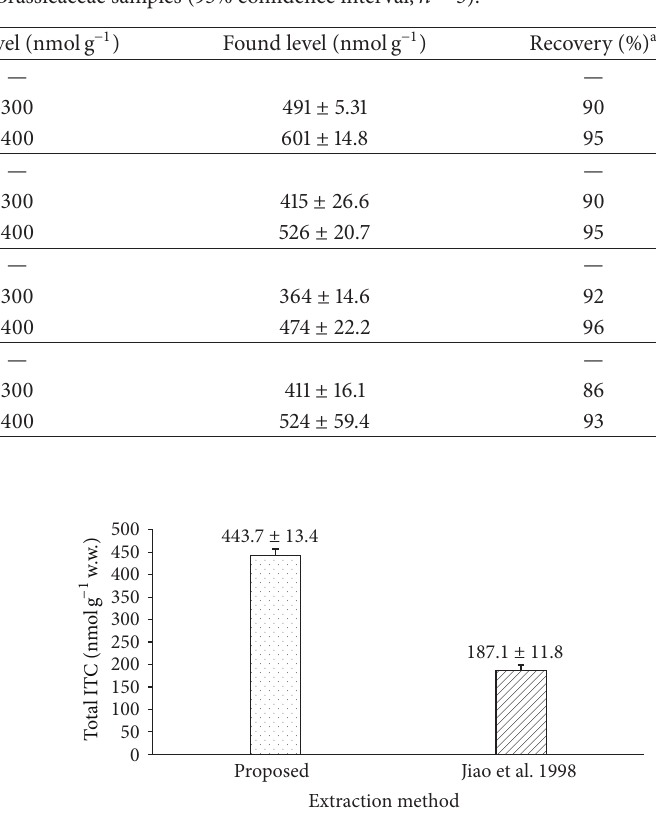
Table 3: Total ITCs concentration found in Brassicaceae samples (95% confidence interval, 𝑛 = 3 ).